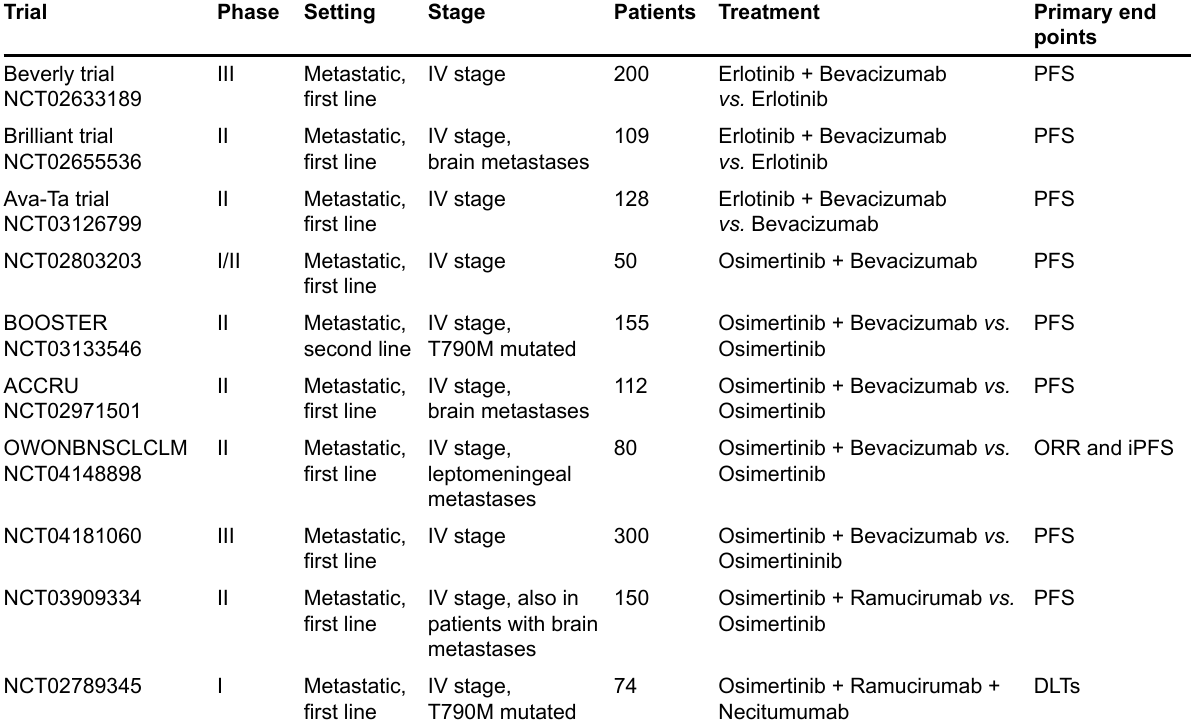
Table 4. Ongoing studies